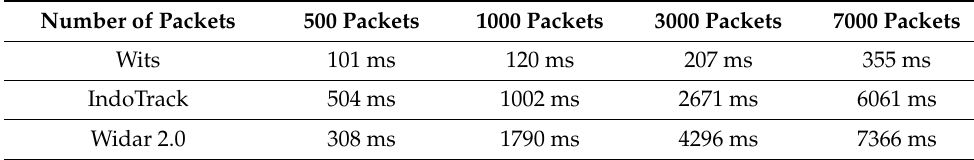
Table 2. The computational time of different